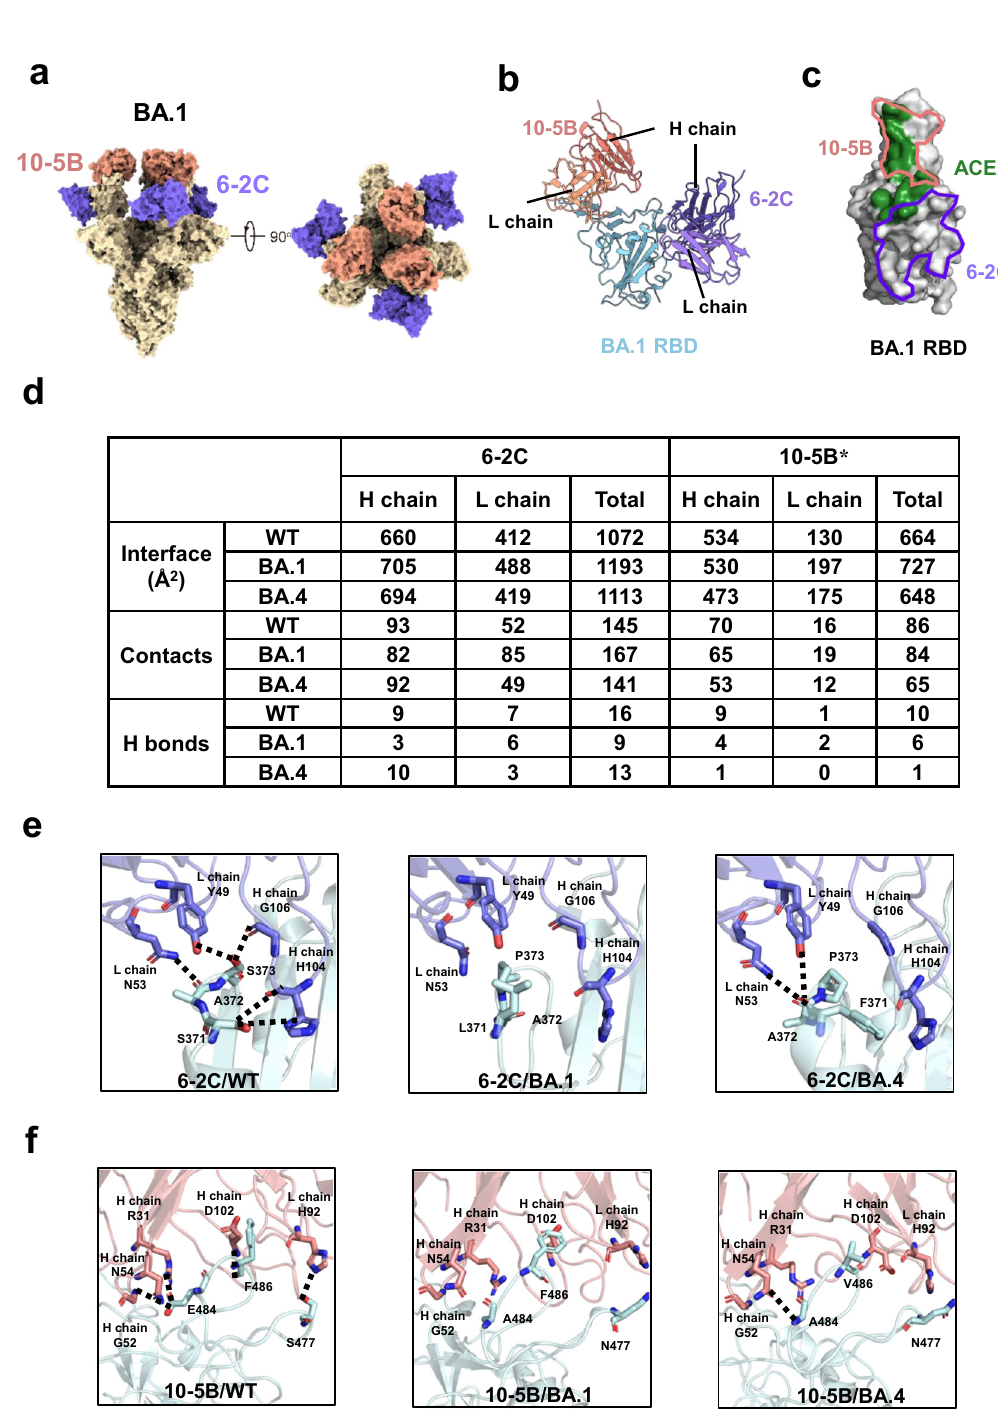
(salmon),6-2C(purple)andACE2(green)footprintsontheBA.1spikeRBD. d Table of 6-2C/10-5B and RBD (WT, BA.1, and BA.4) interactions, including interface area, contacts, and hydrogen bonds. *The values are approximations. e H bonds of 6-2C formed with RBD (WT, BA.1, and BA.4) residues 371, 372, and 373. H bonds are marked by dottedlines. f H bonds and salt bridges of 10-5B formed with RBD (WT, BA.1, and BA.4) residues 477, 484, and